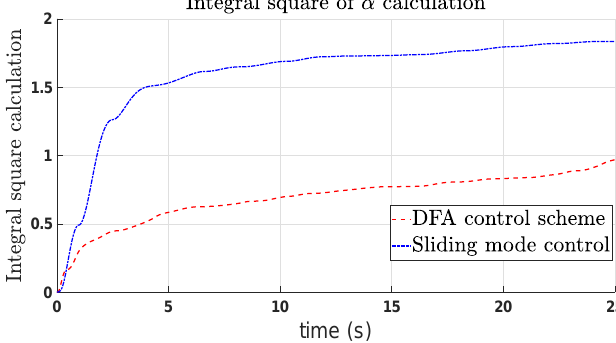
Figure 6. Integral square error index of α